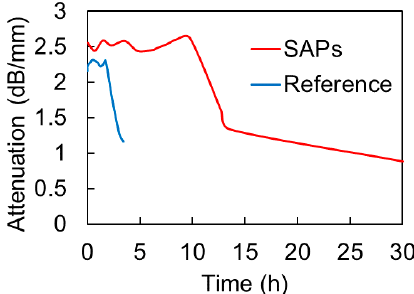
Figure 12. Attenuation of 150 kHz vs. age of cement mortar.